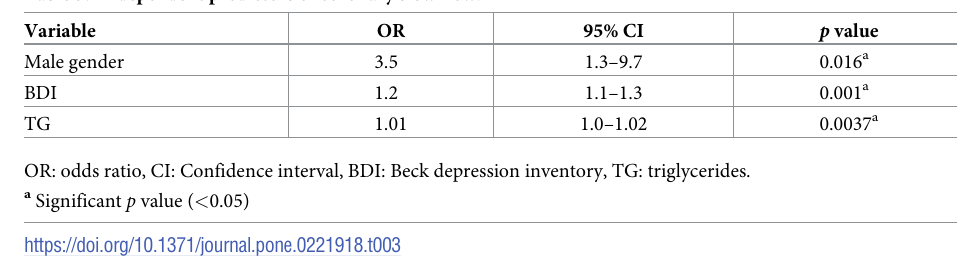
Table 3. Independent predictors of coronary slow